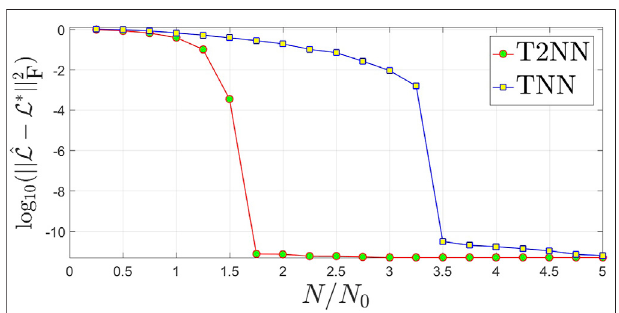
FIGURE 1 | Estimation error in logarithm vs. the normalized observation number N / N 0 for tensor compressed sensing of underlying tensors of size 16×16×16 and rank proxy r =2. The proposed T2NN is compared with TNN